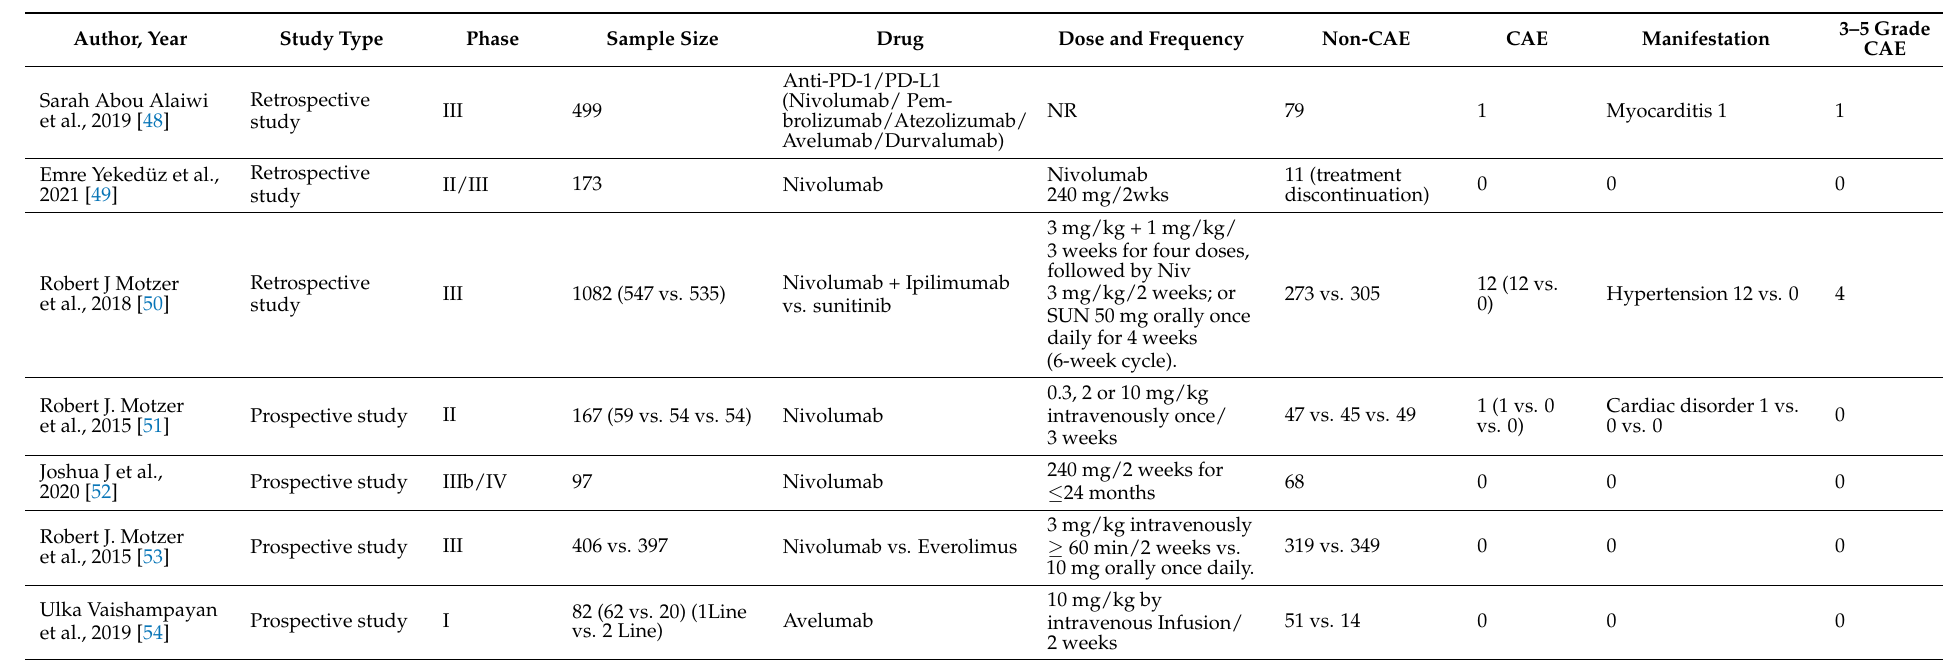
Table 3. Cardiotoxicity in renal cell